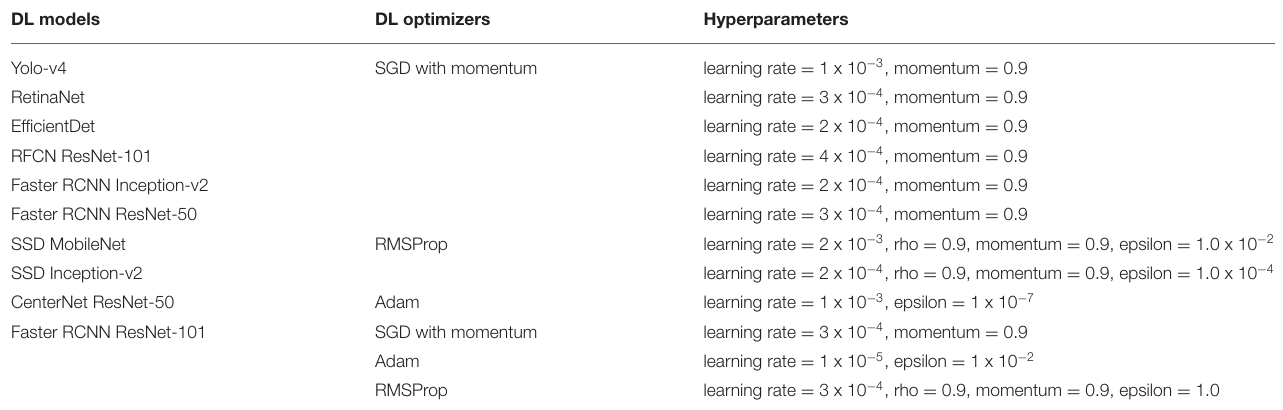
TABLE 2 | Hyperparameters of deep learning optimization algorithms with their respective DL architectures. DL